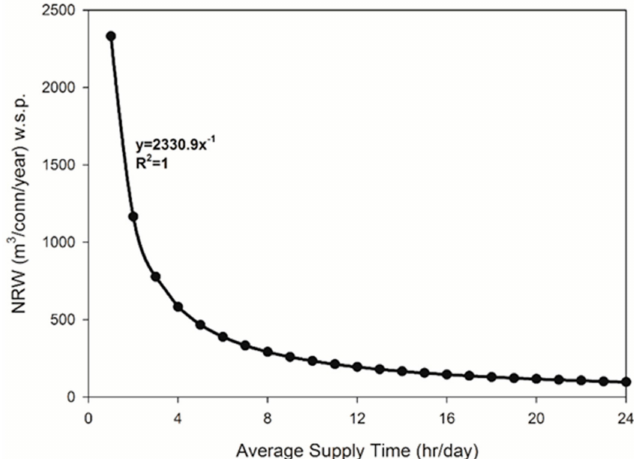
Figure 4. Sensitivity of the normalised NRW volume (w.s.p.) to the average supply time in Sana’a water distribution